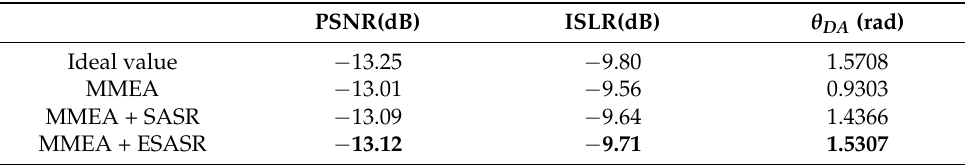
Table 1. Comparison of imaging quality